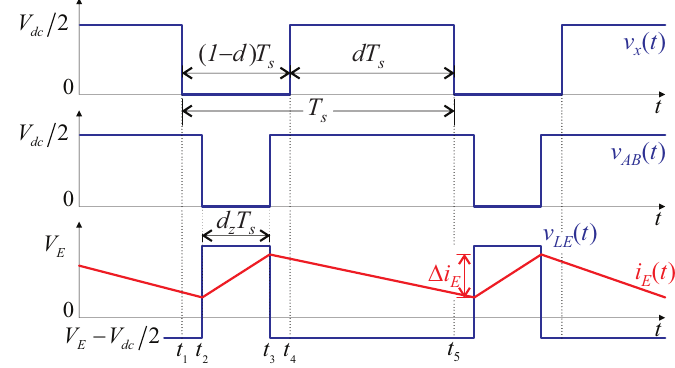
Figure 4. Waveforms detailing the modulation of the ANPC-3P power